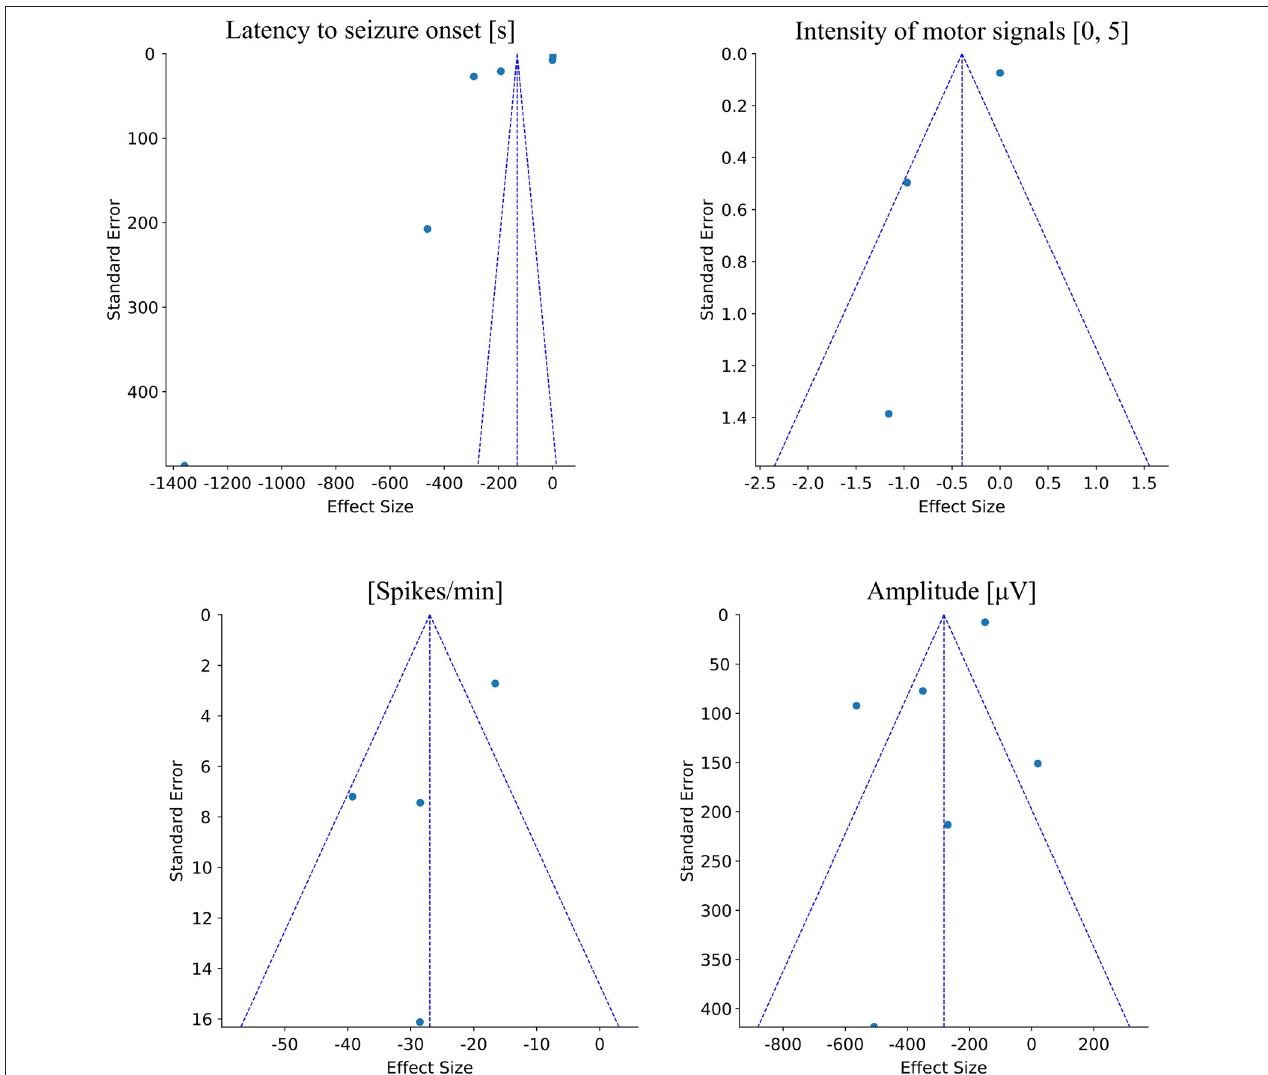
FIGURE 1 | Funnel plots related to each evaluated epileptogenic feature in animal models. The first plot shows the dispersion of the mean effects found in each study related to the latency to seizure onset feature. It is observed that there is an asymmetry among the samples with a leftward trend and high dispersion of the values relative to the limits of the funnel. However, all the effects are located at the top of the funnel showing a low standard error among studies. The second plot shows the dispersion of the effects found in each study related to the intensity of motor signal features. In this plot, it is observed the high heterogeneity among studies and high standard error. Furthermore, since there are only three studies, this plot shows the difficulty in quantitative analysis. The third plot shows the dispersion of the effects found in each study regarding the spikes/min feature. In this plot, it is possible to observe a considerable dispersion among the samples, mainly due to one study showing a high standard error. Although there is a significant overall effect favorable to physical exercise, corroborated by the asymmetry in the funnel plot, this dispersion pattern also demands an increase in the number of studies to improve the stability of the meta-analysis inference. The fourth figure shows the dispersion of the effects found in each study regarding the amplitude of spikes feature. It is possible to observe an effect of dispersion symmetry with a good homogeneity in the standard error among most studies. There is only one sample with a high standard error, but the lateralization of the overall effect in favor of exercise in the mitigation of epileptogenic effects corroborates the